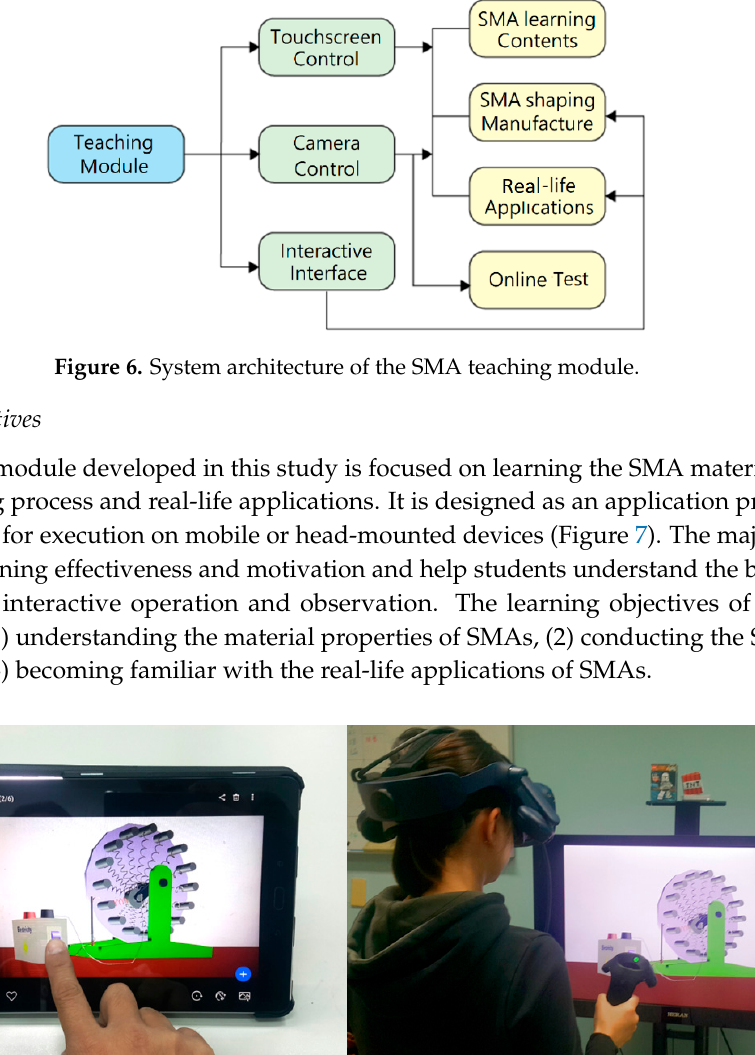
Figure 5. Using Unity3D to design the user interface in the virtual experiment.